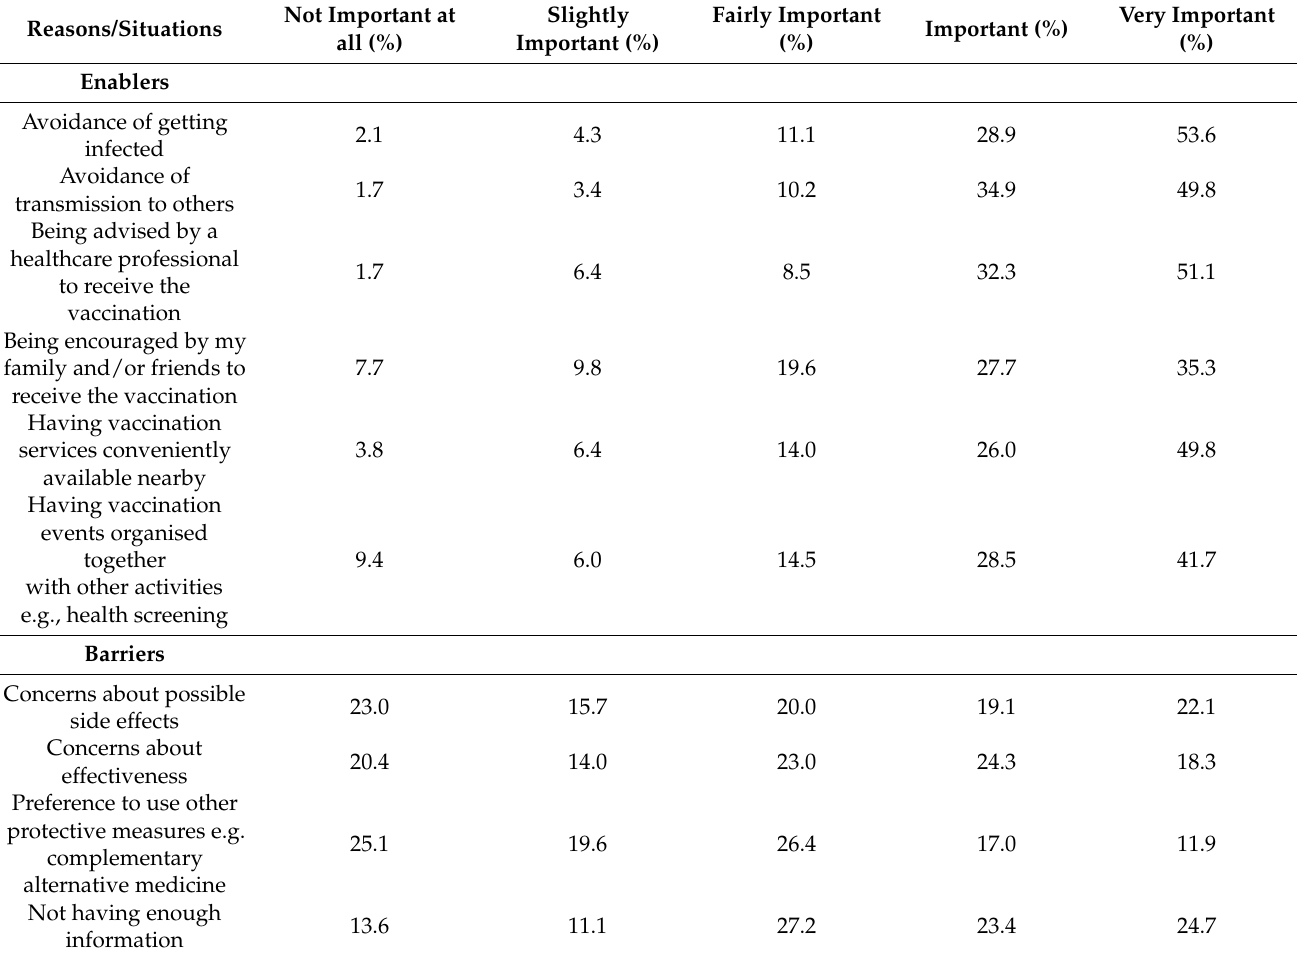
Table 4. Intention for future vaccination (N =